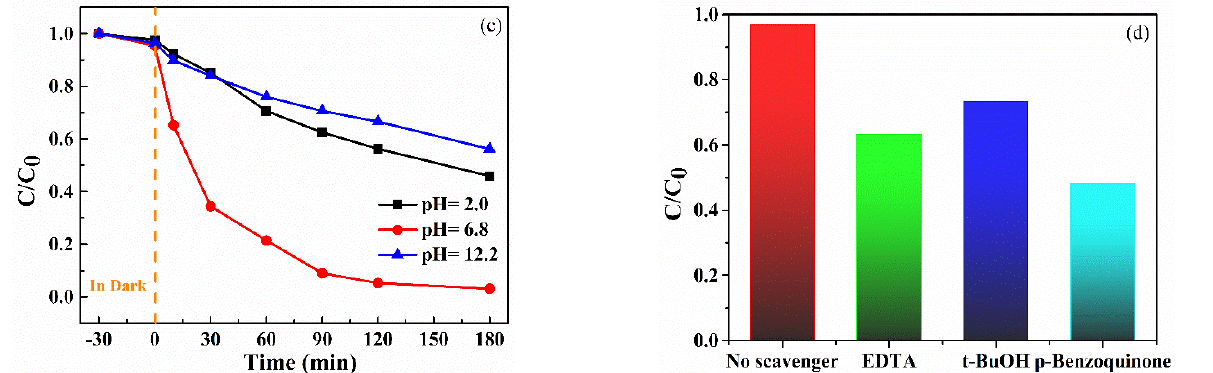
Figure 6. Photodegradation of RhB over CTO and MoS 2 /CaTiO 3 composites ( a ) and kinetic plots ( b ), at different initial pH ( c ), and different scavengers ( d ) of the RhB degradation over the samples.